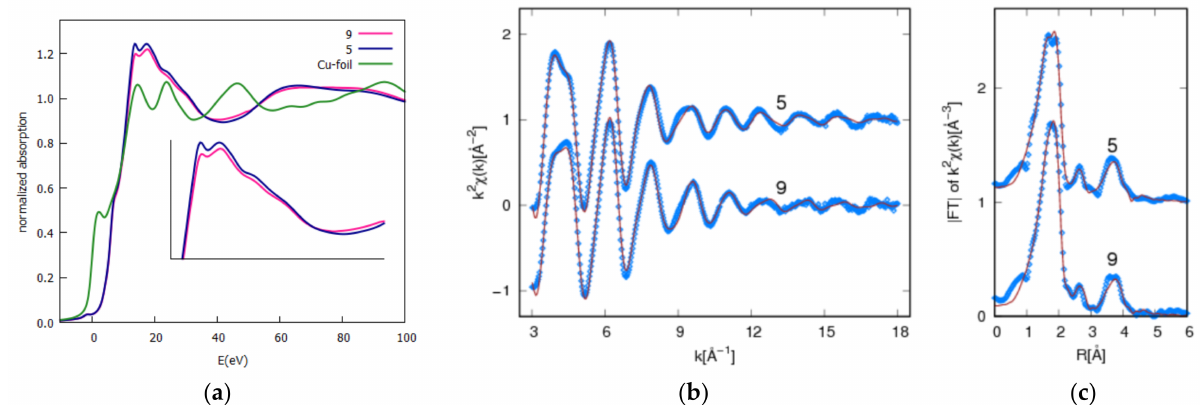
Figure 5. ( a ) Cu K edge normalized spectra in the near edge (XANES) region for complex 5 , 9 , and Cu reference metal foil. The spectra of 5 and 9 depict weak but evident differences in the XANES region (inset panel a); ( b ) k 2 -weighted experimental (blue dots) EXAFS data and best fit (brown lines) curves for complexes 9 and 5 (vertically shifted for clarity); ( c ) moduli of k 2 χ ( k ) Fourier transforms (|FT|) of experimental (blue dots) and best fit (brown lines) curves. The |FT| maxima represent the main neighbor coordination distances (uncorrected for the phase